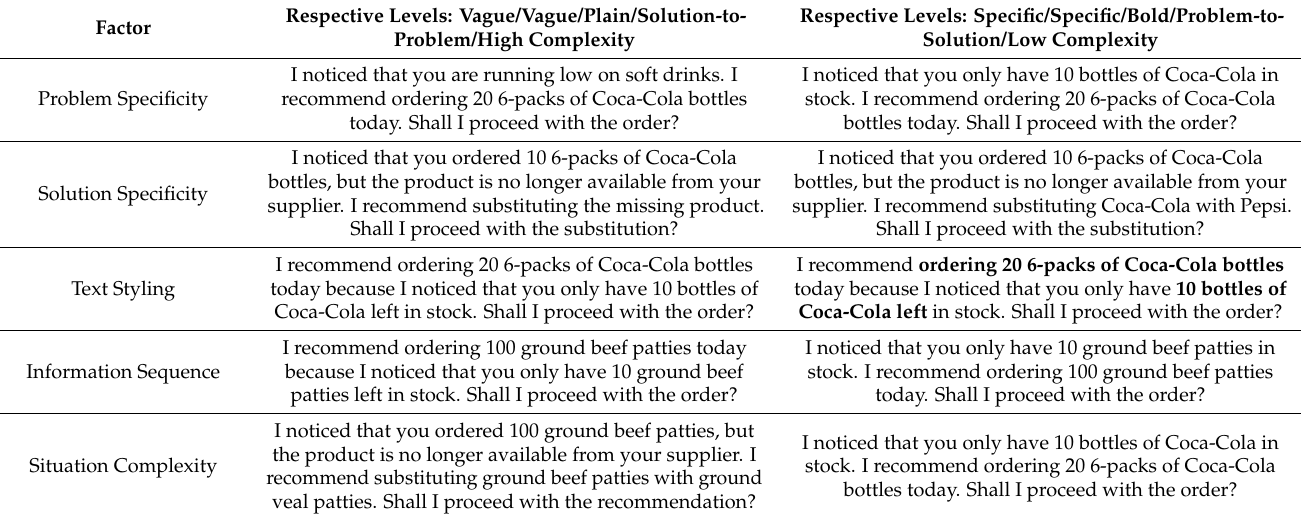
Table 1. Experimental manipulation of independent